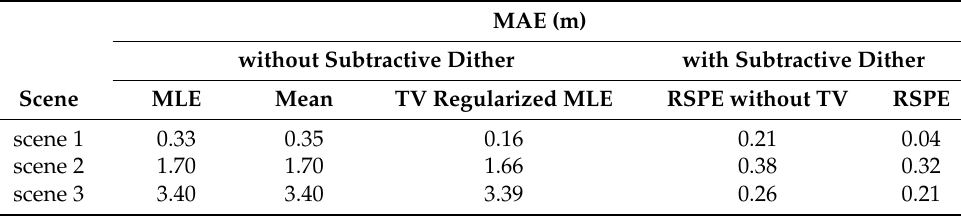
Table 1. MAE performance of the depth estimates with different methods.